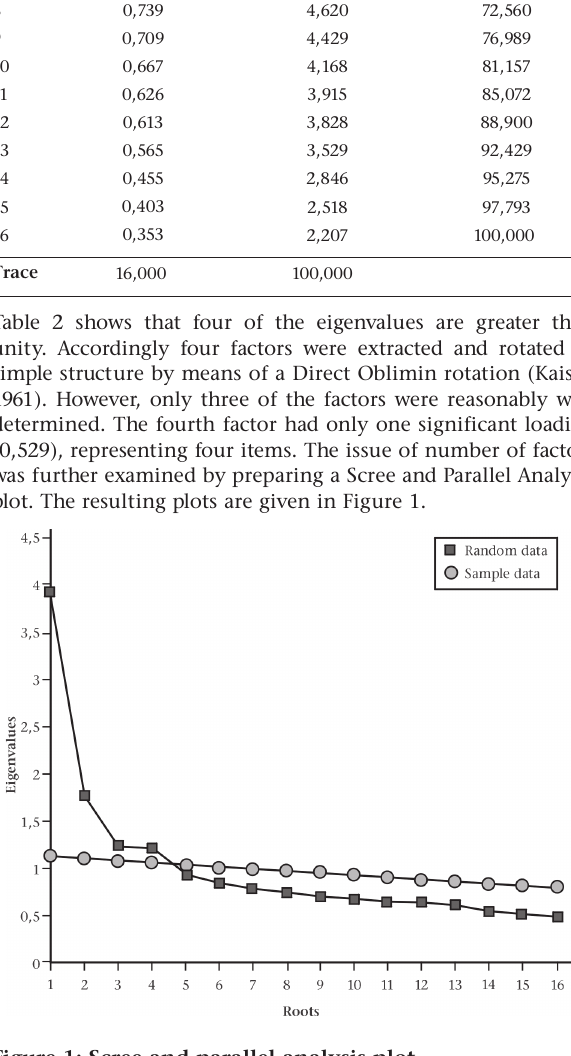
Figure 1: Scree and parallel analysis